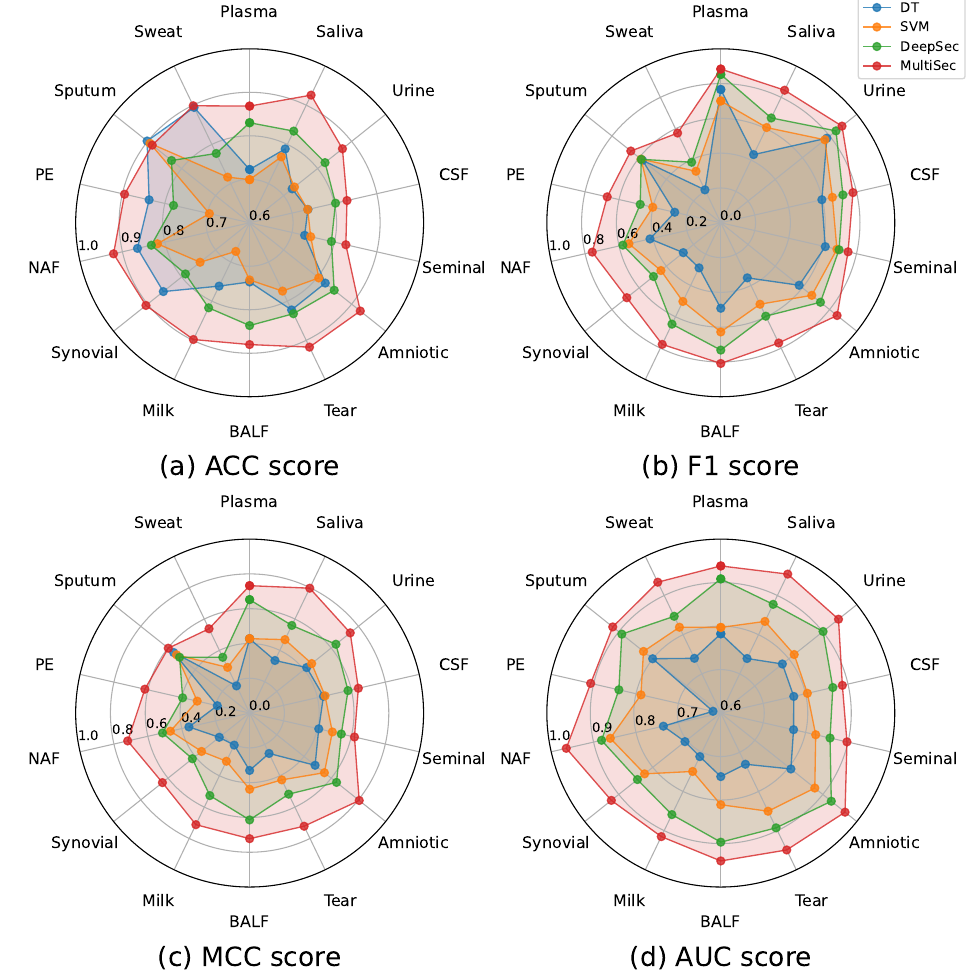
Figure 2. Radar charts of comparative benchmarks on the independent testing datasets corresponding to 14 human body fluids. Higher is better: ( a ) radar chart of accuracy in 14 human body fluids; ( b ) radar chart of F1 score in 14 human body fluids; ( c ) radar chart of Matthew’s correlation coefficient in 14 human body fluids; ( d ) radar chart of area under the ROC Curve in 14 human body